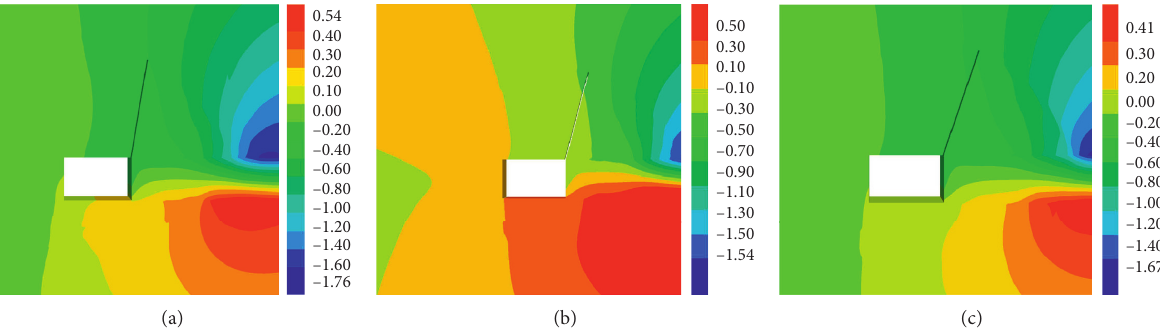
Figure 8: Vertical displacement distribution of different roof cutting heights (m). (a) Roof cutting angle is 10 ° . (b) Roof cutting angle is 15 ° . (c) Roof cutting angle is 20 ° .